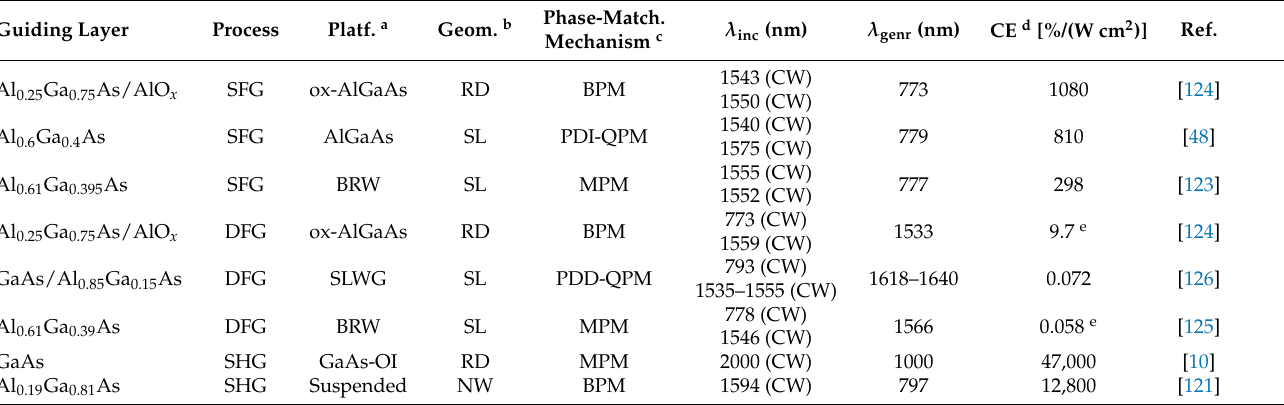
Table 4. Normalized conversion efficiencies (CE) and phase-matching mechanisms for second-order processes in AlGaAs